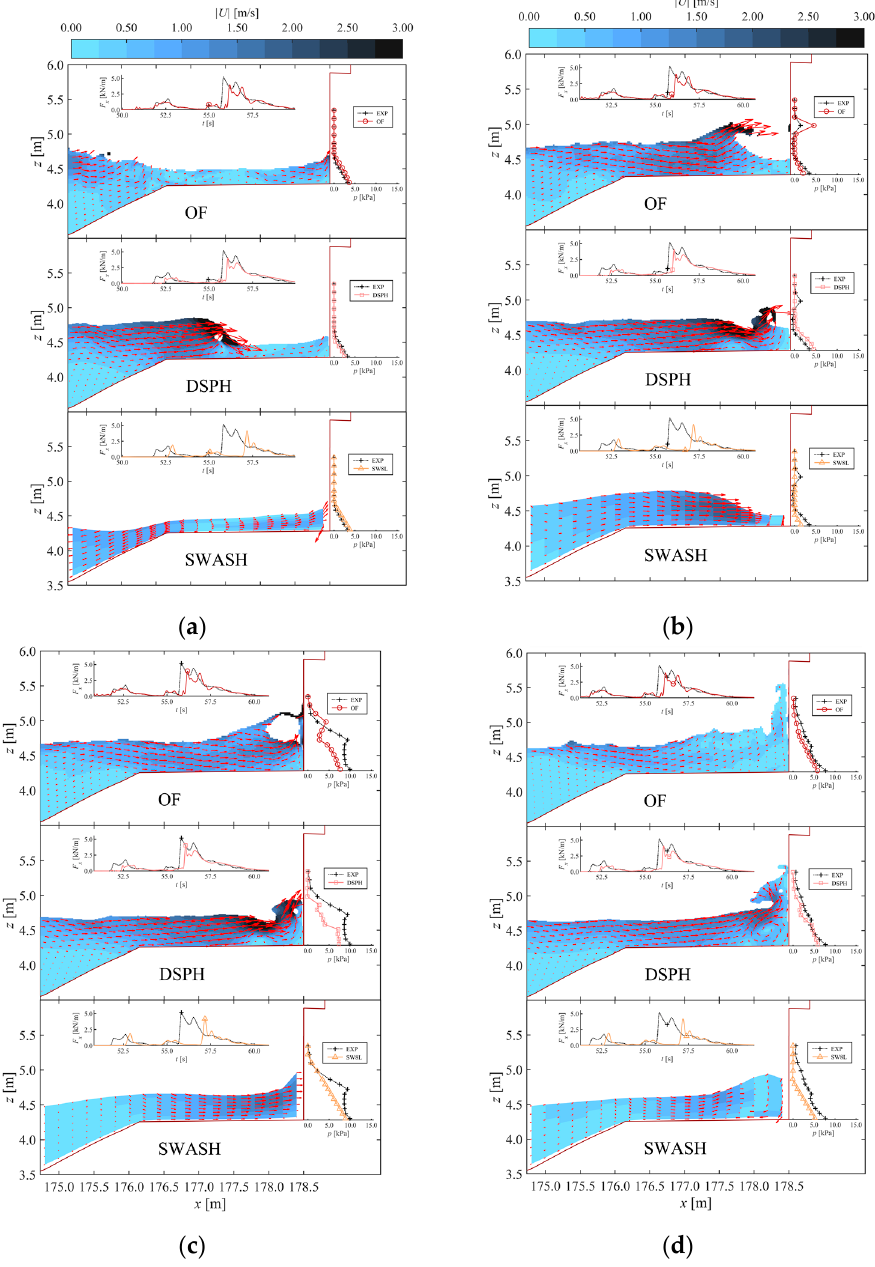
Figure 15. Numerical comparative snapshots of the water flow on the dike. Colours are the velocity magnitude | U | according to the colour scale shown at the top of each figure. The red arrows are the velocity vectors, which are scaled for a clear visualisation. Each model snapshot has two inset graphs: at the top is a time series plot of F x in which a marker indicates the time of the snapshot, and along the vertical wall p is plotted at each pressure sensor location (vertical axis is z [m]). Adapted from the work in [3], with permission from the authors, 2020. ( a ) Time instant 1; ( b ) time instant 3; ( c ) time instant 4; ( d ) time instant 5.